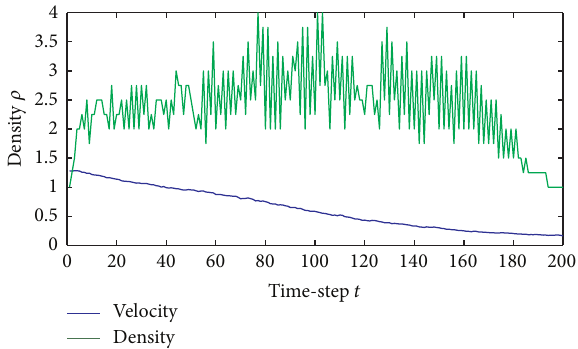
Figure 6: Velocity-time relation and density-time